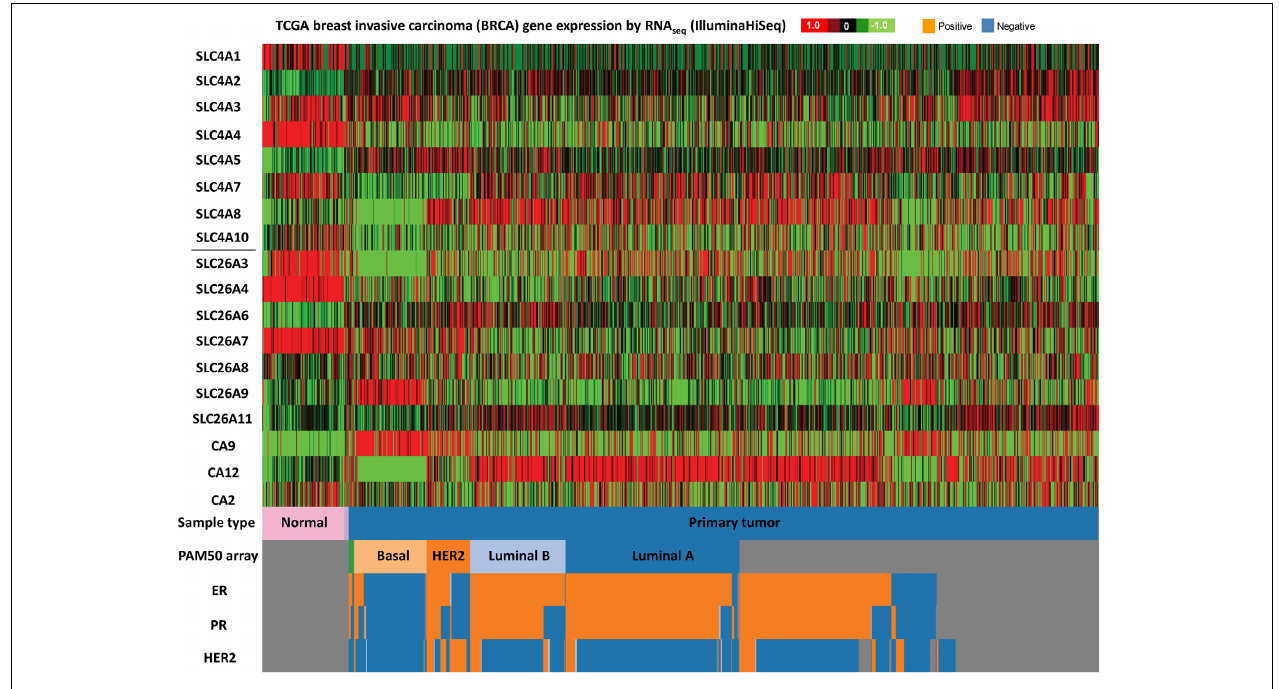
FIGURE 4 | SLC4 and SLC26 family mRNA expression levels in breast cancer. RNA sequencing data (ID: TCGA_BRCA_exp_HiSeqV2, N = 1106) from The Genome Cancer Atlas database was processed and visualized with UCSC Cancer Genomics Browser (https://genome-cancer.ucsc.edu). The